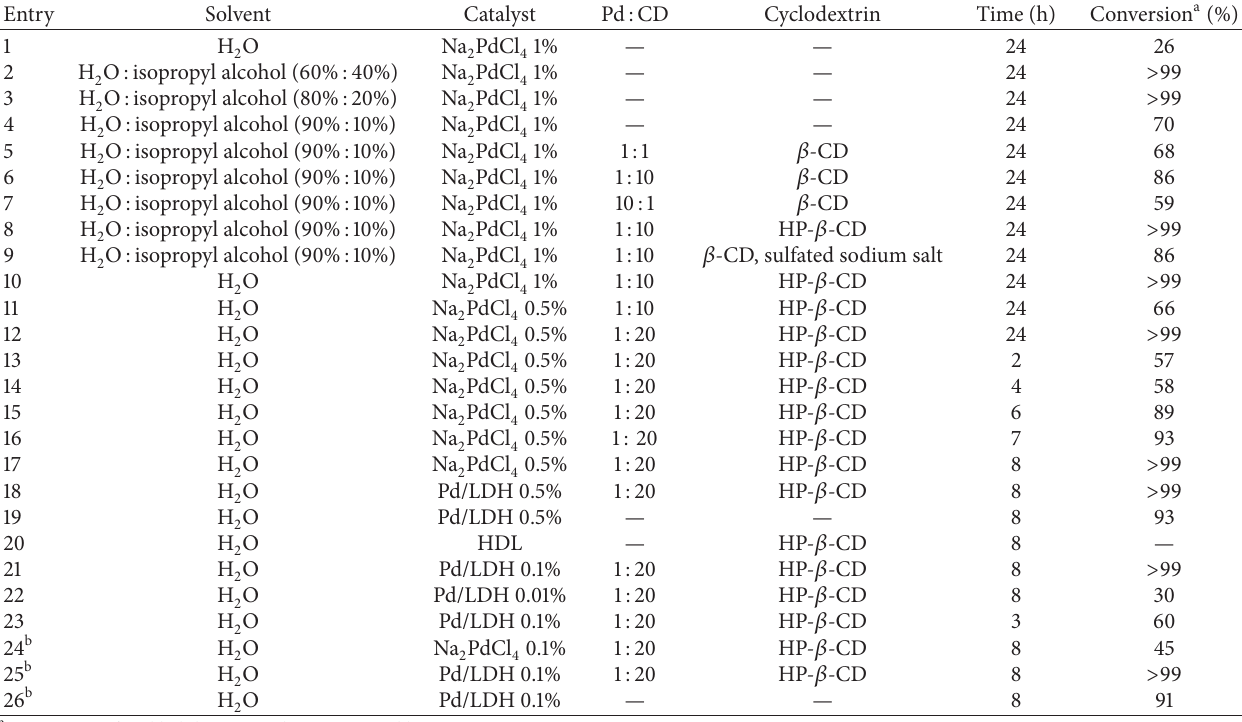
Table 3: Screening of the best condition for the Suzuki reaction between 4-bromoacetophenone and phenylboronic acid.